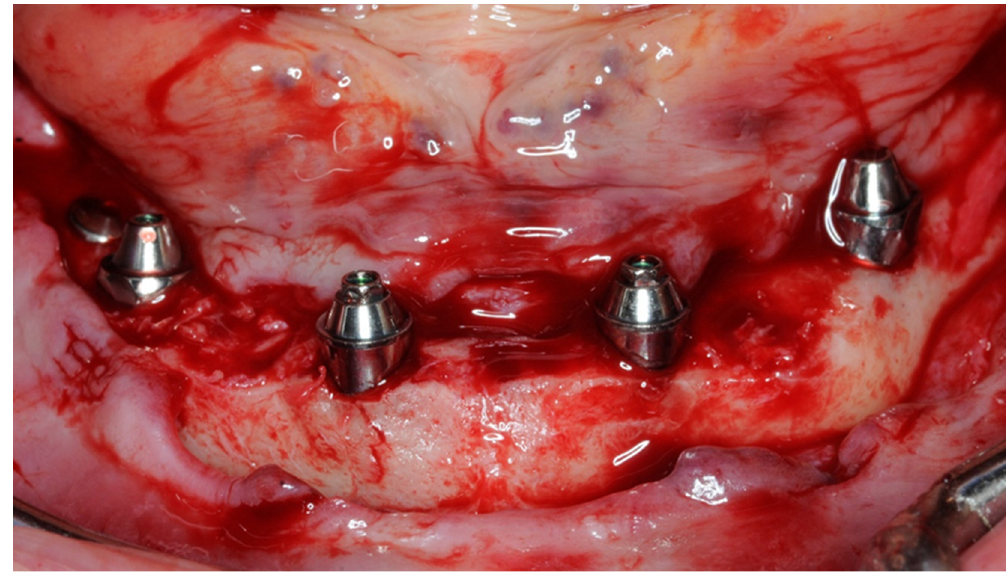
Figure 1. Implant position with MUA, showing the distribution of implant emergences .